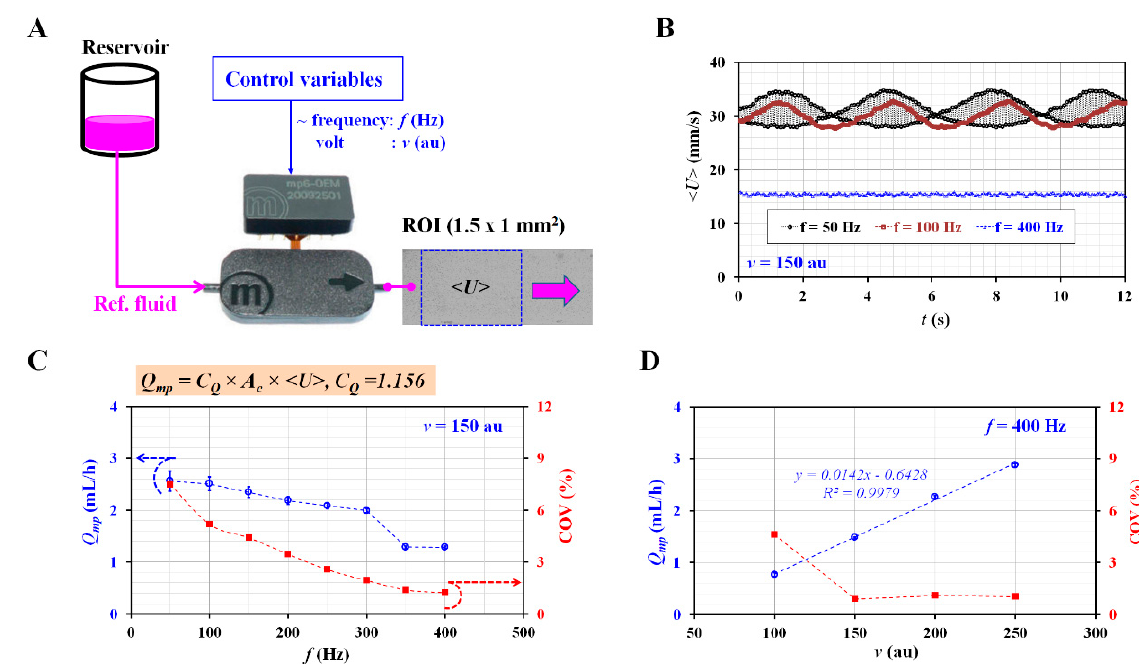
Figure 3. Quantitative evaluation of flow rate of reference fluid varied by setting control variables (i.e., frequency and voltage) of a controller connected to a micropump. ( A ) Schematic diagram of the experimental setup. ( B ) Temporal variations of < U > with respect to f = 50, 100, and 400 Hz. Here, the voltage was set to v = 150 au. ( C ) Variations of Q mp and COV with respect to f = 50, 100, 150, 200, 250, 300, 350, and 400 Hz. Here, the voltage was set to v = 150 au. The flow rate of the micropump ( Q mp ) was obtained as Q mp = C Q × A c × < U >. The corrector factor ( C Q ) was given as 1.156. ( D ) Variations of Q mp and coefficient of variance (COV) with respect to v = 100, 150, 200, and 250 au. Here, the frequency was set to f = 400 Hz.